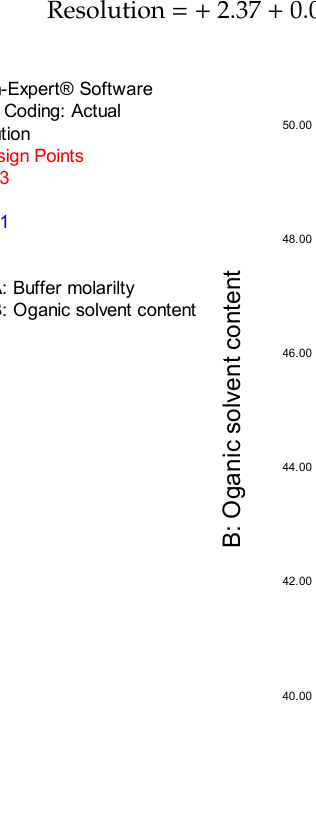
Figure 7. Contour plot depicting the impact of ACN content and buffer molarity on peak resolution. ACN content and buffer molarity can be manipulated to improve peak resolution. The contour plot suggests that increased peak resolution will be obtained when a buffer molarity of 50 mM and ACN content of approximately 40% v/v is used. The equation for peak resolution (Y 3 ) is reported in Equation 4.